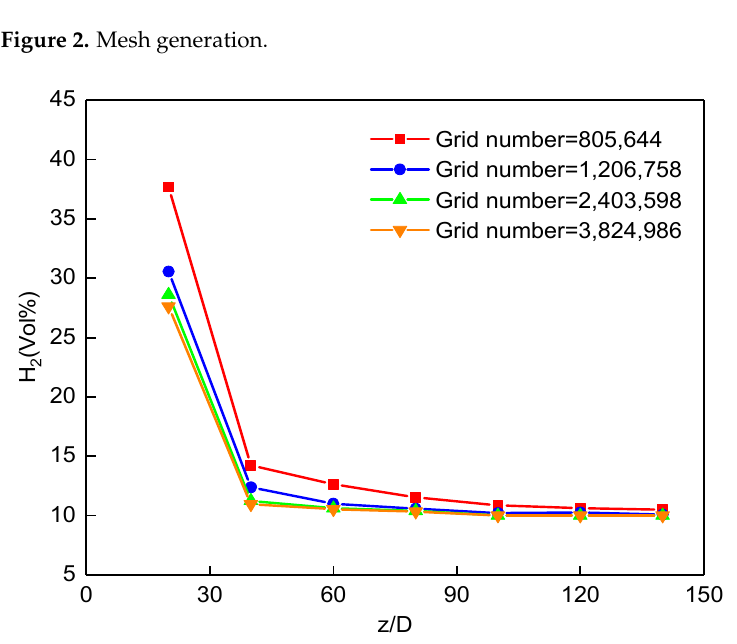
Figure 3. Validation of grid-independent solution.